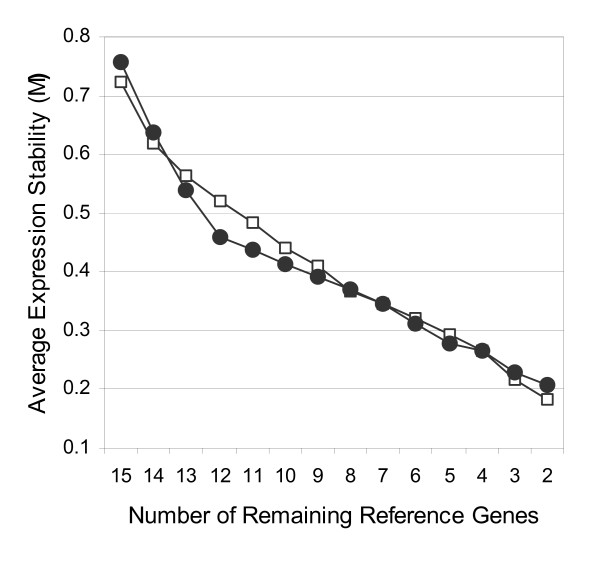
geNorm ranking of reference genes over a grape berry development series. 2003 pericarp series (□) and 2004 pericarp series (●). Ranked genes are shown in Table 2. Initially, expression stabilities (M) are calculated for each gene and the average M for all genes is plotted. Then the least stable gene is eliminated from the set and new M values are calculated in an iterative process until only two genes remain.